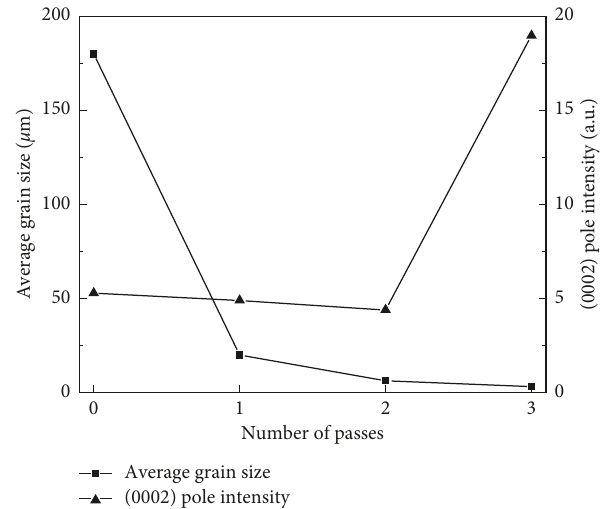
Figure 12: Relationships between average grain size, (0002) pole intensity, and number of CEE